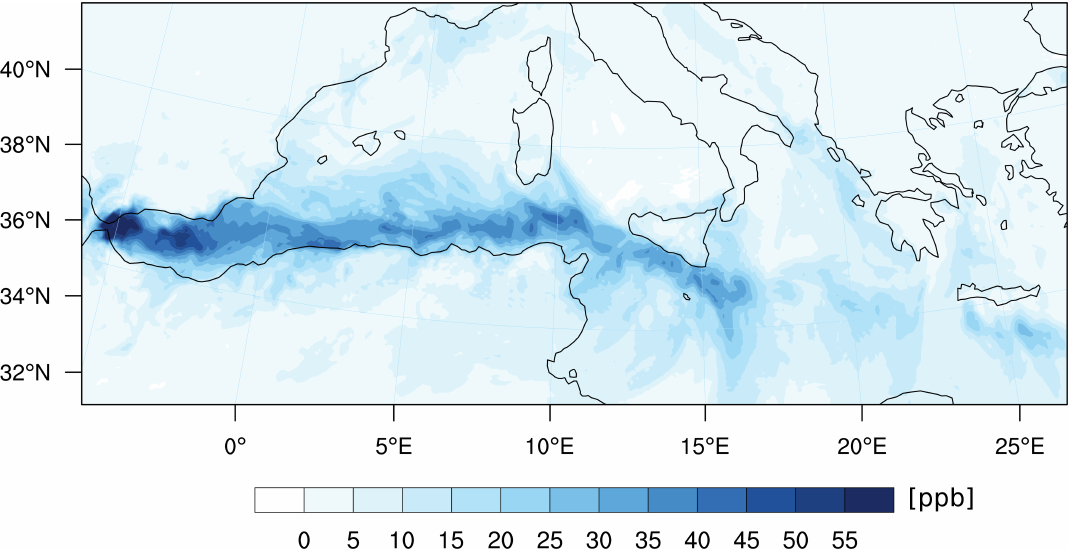
concentrations between the Tot_emiss 3